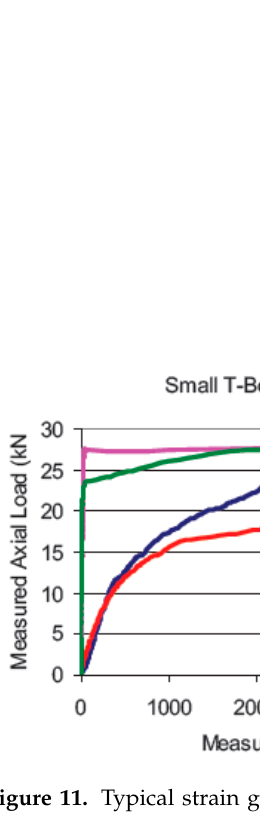
Figure 11. Typical strain gauge readings during the loading process of the CFRP strips bonded to the “unit T-beam” specimens ( a ) CFRP strips without any anchors (Figures 8b and 9a) ( b ) CFRP strips with steel anchors (Figures 8c and 9b).